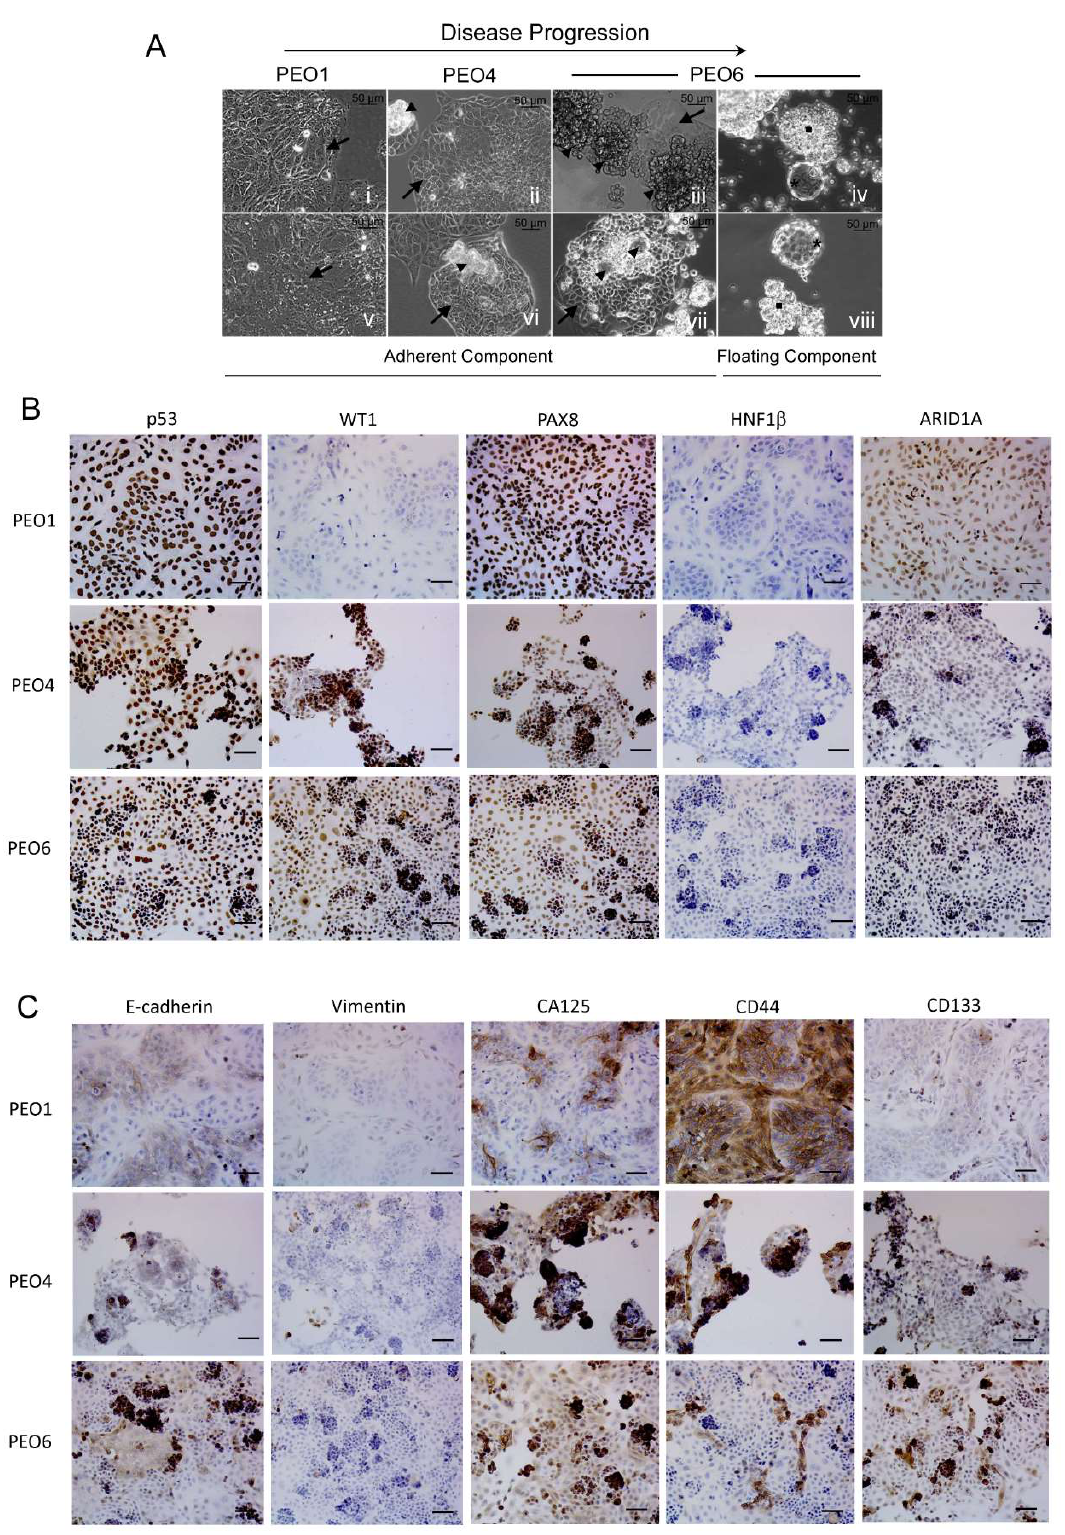
Figure 1. ( A ) PEO1, PEO4, and PEO6 cells were cultured for 10 days in media with 10% serum, including insulin and antibiotics. Arrows : adherent cells. Arrowheads : 3D foci. Squares : irregular multicellular structures. Asterisks : spheroidal multicellular structures. ( B ) Expression of biomarkers of HGSOC in cultured PEO1/4/6 cells. ( C ) Expression of markers of epithelial-mesenchymal transition and of stem cell plasticity in PEO1/4/6 cells. Scale bars = 50 μm.